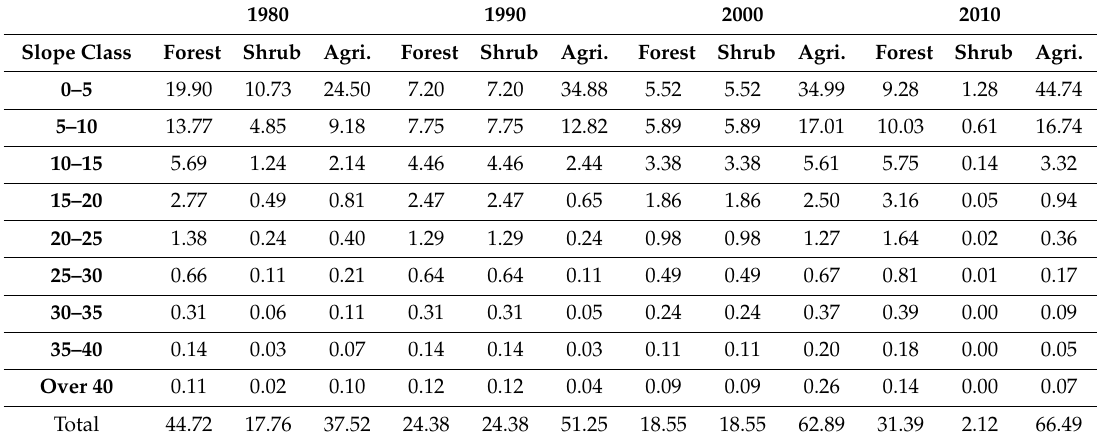
Table 8. Province 2: land use as a percentage of total area of forest, shrubland, and agriculture for 1980, 1990. 2000, and 2010 for entire Nepal. ((Individual land-use area for a slope class / sum of forest + shrubland + agriculture) * 100).